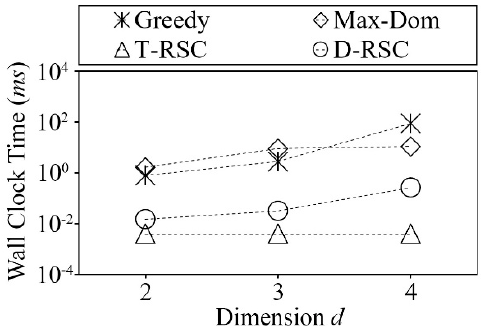
Figure 10. Comparison of re-computation time on synthetic dataset (varied d ).